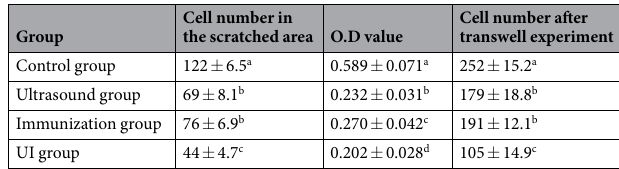
Table 4. Cell num ber in the scratched and transwell area and O.D value in each group. (Statistical index labeled with different characters P <